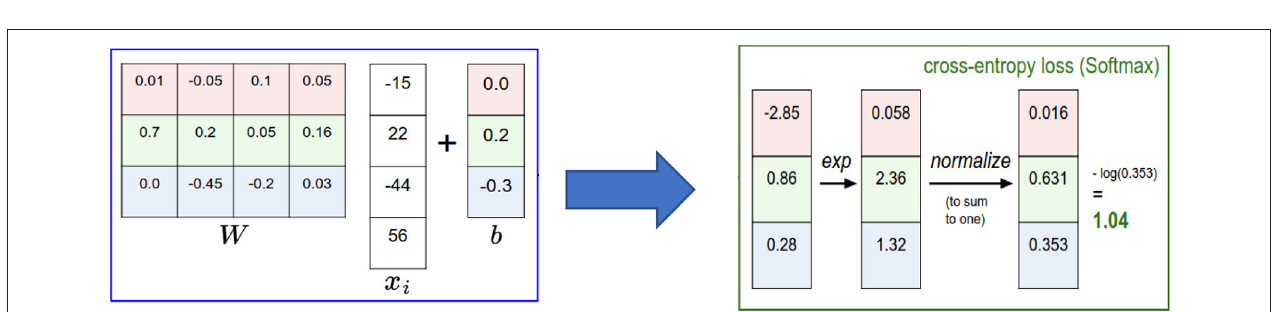
FIGURE 6 | A two-class SVM classifier: An example for one data point using hinge loss (Li, 2019).